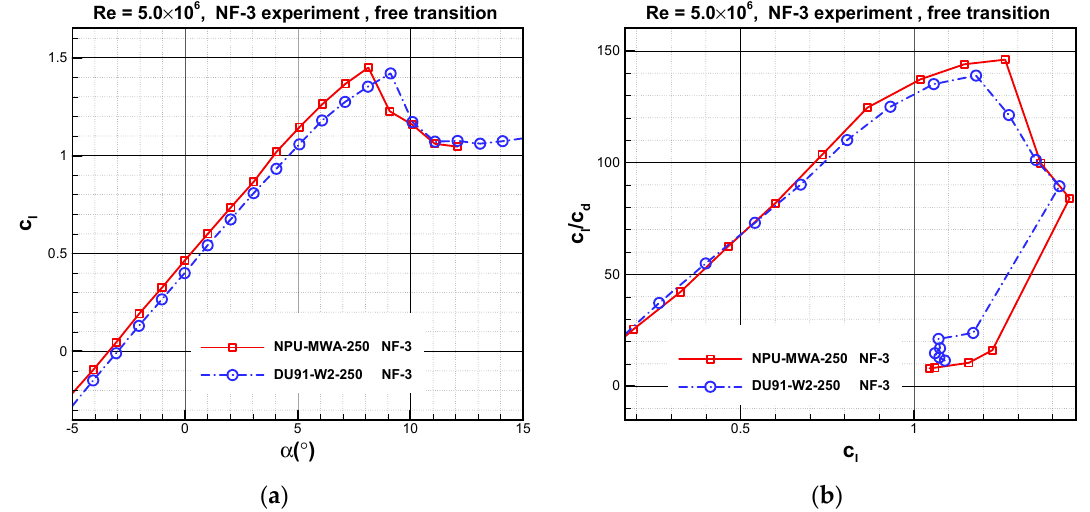
Figure 5. Comparison of experimental data for the NPU-MWA-250 airfoil and DU91-W2-250 airfoil: ( a ) lift curves; ( b ) lift-to-drag ratio curves.